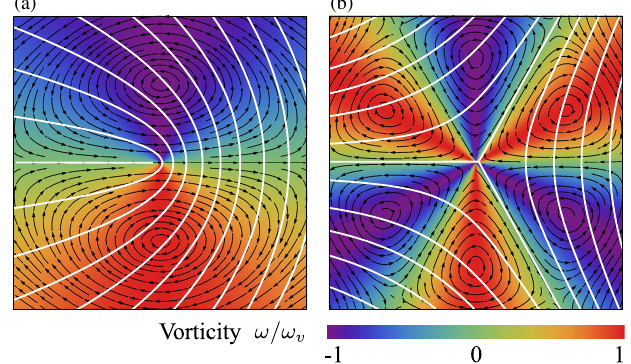
FIG. 6. The flow field generated by a þ 1 = 2 (a) and − 1 = 2 disclination (b). The white lines indicate the orientation of the director field. The black arrows correspond to the flow velocity while the background color indicates the vorticity. The flow is obtained from an analytical solution of the incompressible Stokes equation in the presence of a body force f (cid:3) ¼ ∇ · ð α Q (cid:3) Þ and Q (cid:3) the nematic tensor associated with a (cid:3) 1 = 2 disclination [25].